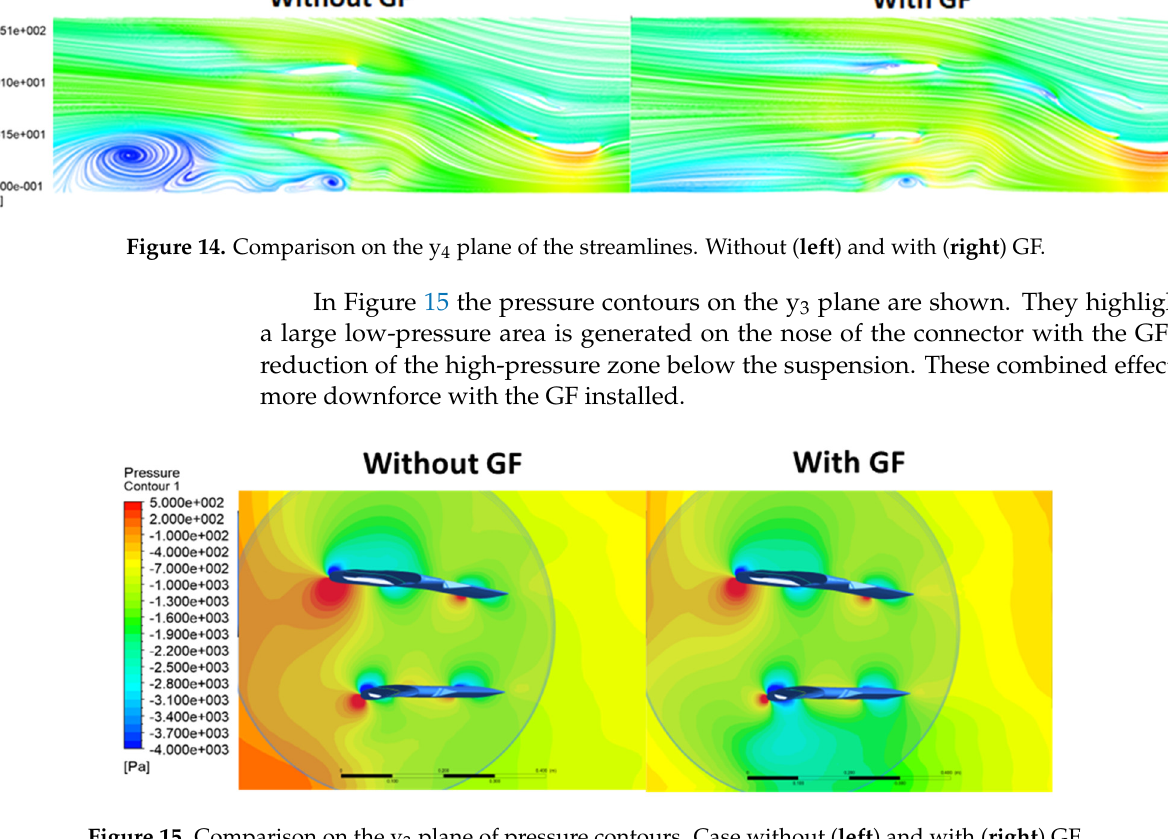
Figure 15. Comparison on the y 3 plane of pressure contours. Case without ( left ) and with ( right ) GF. The pressure contours on the x 4 plane are shown in Figure 16 to discuss the various aerodynamic effects acting on the other parts of the